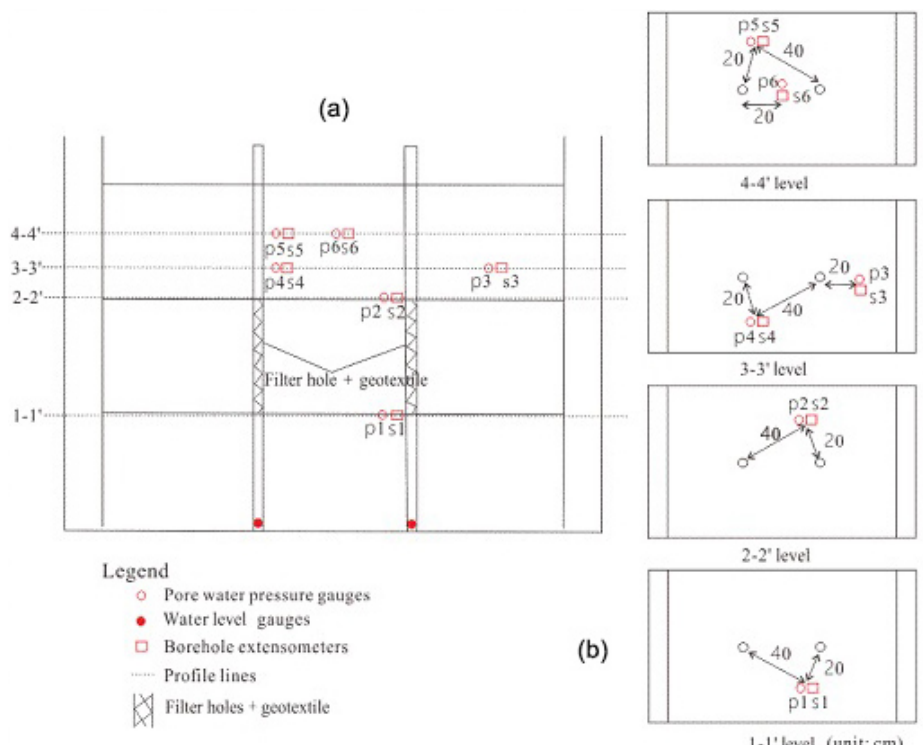
Figure 2. Model profile and embedded sensor schematic diagram ( a is a cross-section through the model, and b is a plane view at different